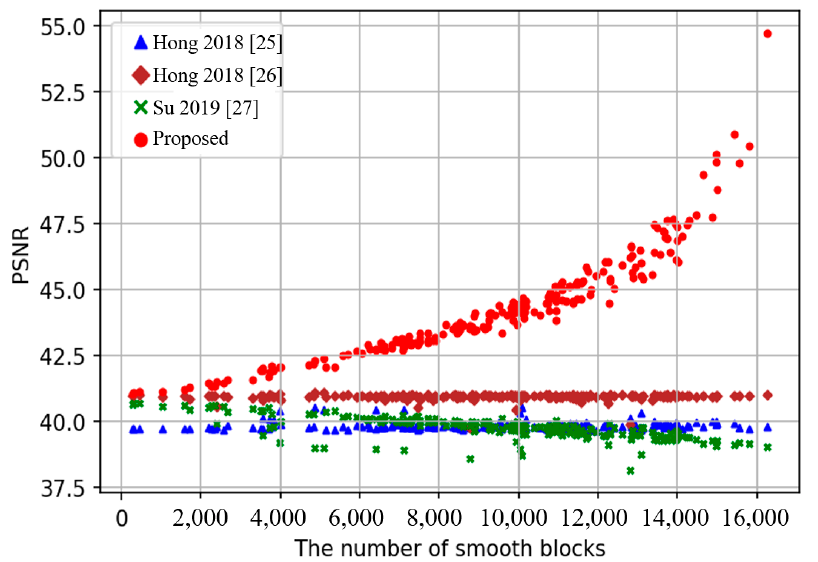
Figure 6. Comparisons between PSNR and the number of smooth blocks for 200 images.